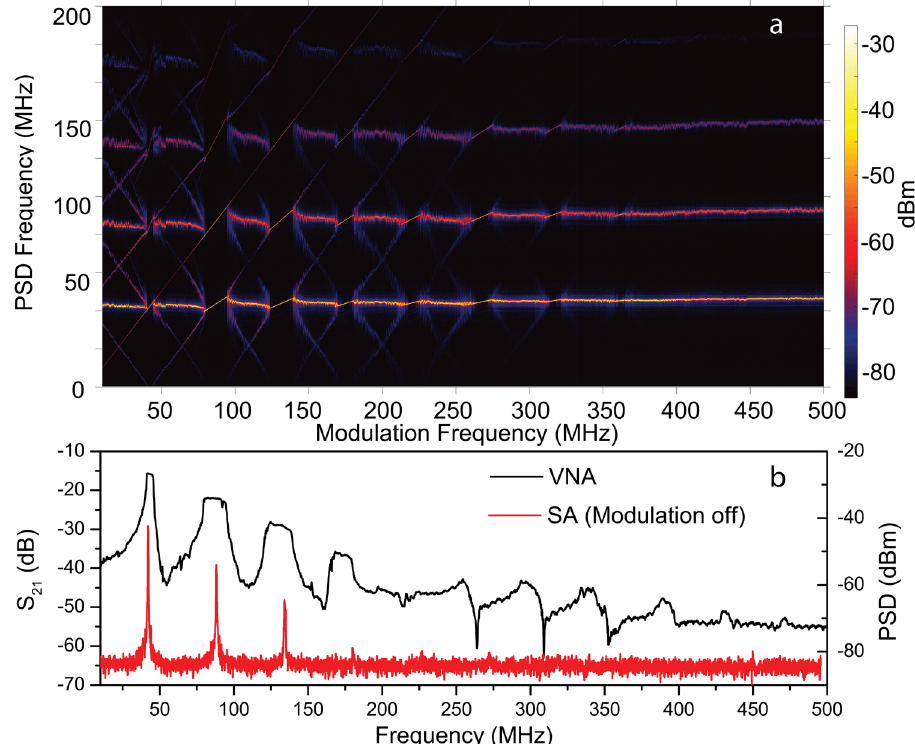
Fig. 3 Injection locking to higher self-pulsing harmonics. a Colour contour plot of the power spectral density (PSD) spectra as a function of the modulation frequency covering a range between f mod = 10 MHz and 500 MHz to for a modulation amplitude of P mod = ±3.4%. The PSD power is quanti fi ed in dBm in the colour scale. b Coherent frequency response of the re fl ected optical signal (S 21 ) measured in the vector network analyzer (VNA) as a function of the modulation/detection frequency (black curve, left axis) and PSD spectra measured in the spectrum analyzer (SA) when the modulation is off (red curve, right